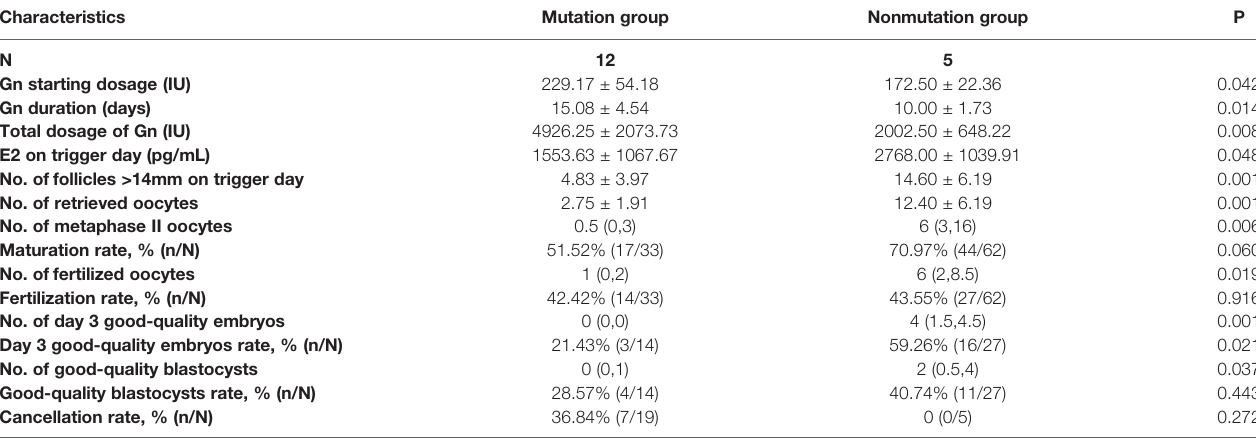
TABLE 3 | The cycle characteristics and reproductive outcomes of ART in BPES patients with and without FOXL2 mutations. Characteristics